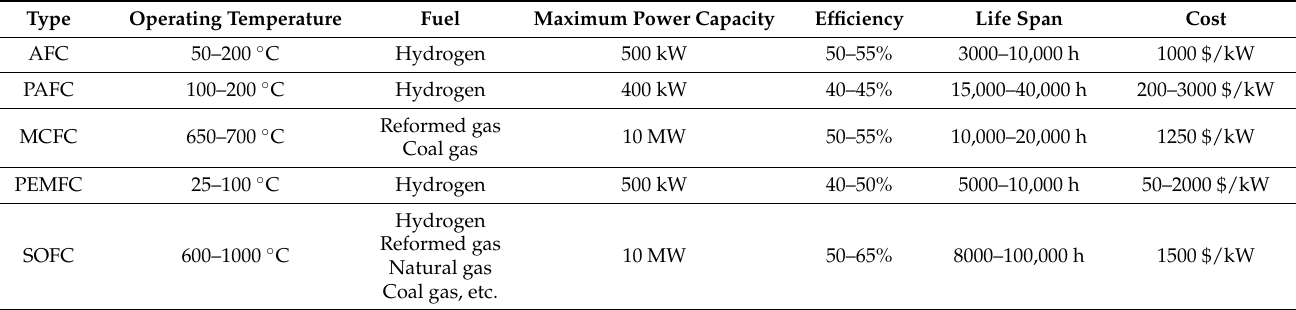
Table 1. Parameters of five typical types of fuel cells